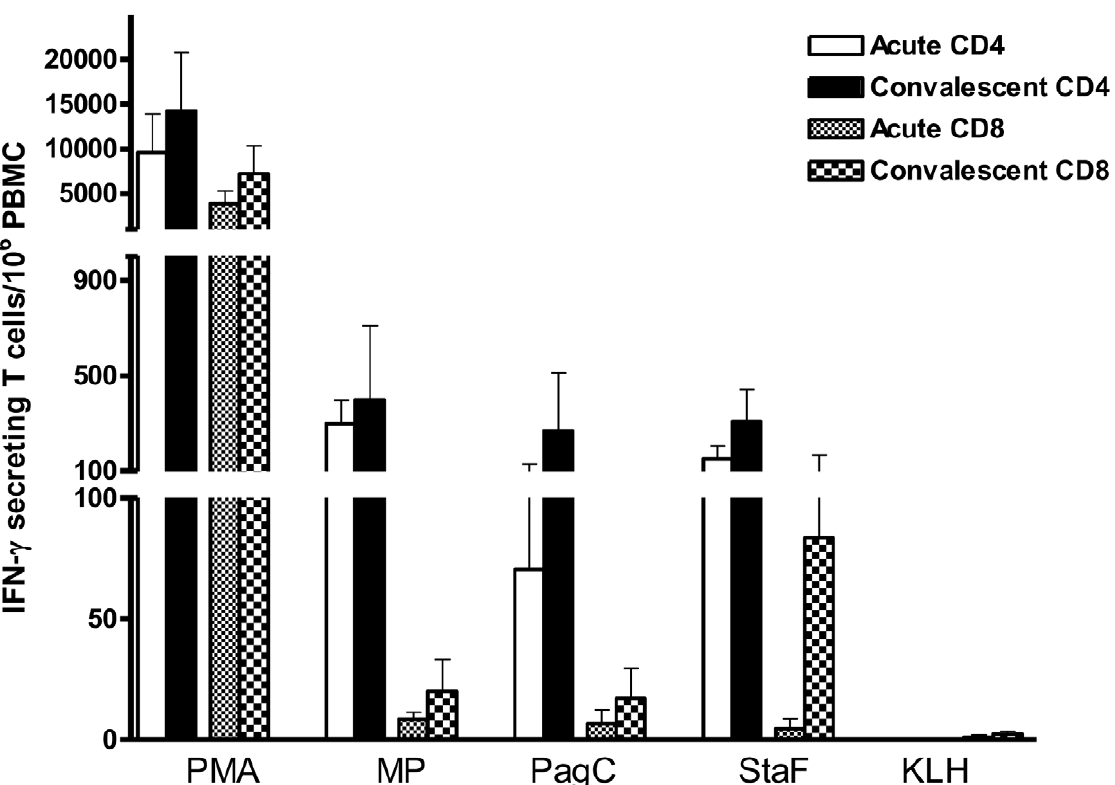
Figure 2. Characterization of interferon- c CD4 and CD8 responses to S . Typhi antigens including StaF (STY0202), PagC (STY1878), S . Typhi membrane preparation (MP), and PMA and keyhole limpet hemocyanin (KLH) during acute and convalescent stage illness in S . Typhi bacteremic patients. Mean and standard error of the mean represented.